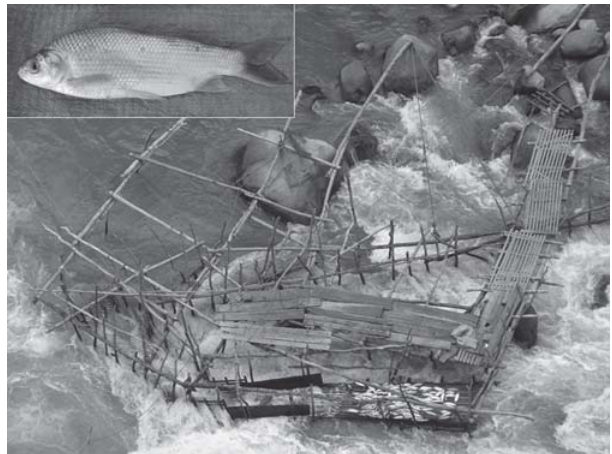
Fig. 2. Fish trap in the Pilcomayo River. In the inset the Sábalo ( Prochilodus lineatus